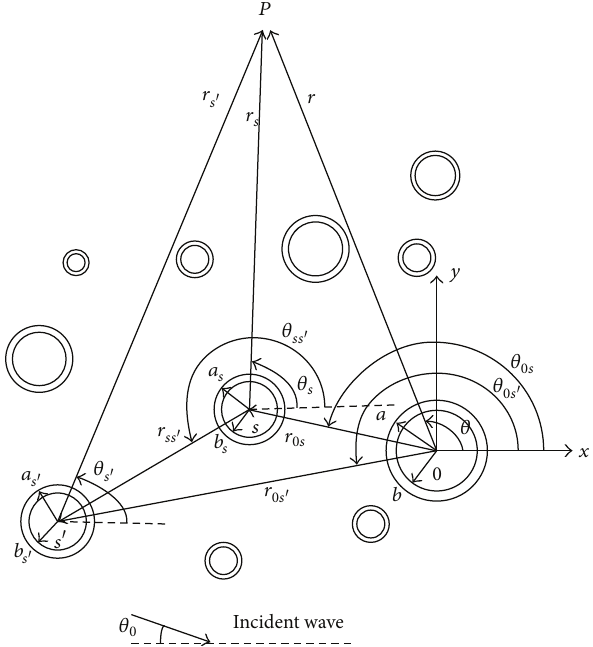
Figure 1: Geometric model and analysis coordinate systems.